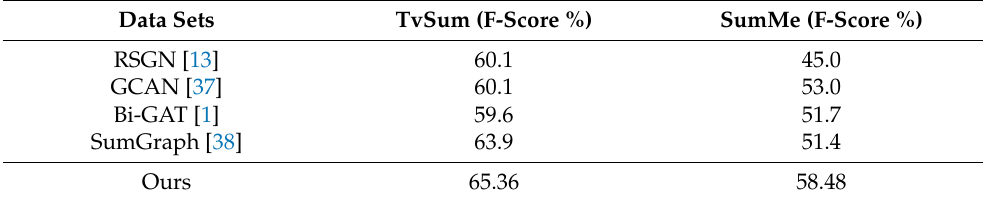
Table 6. Performance analysis of methods based on “Graph